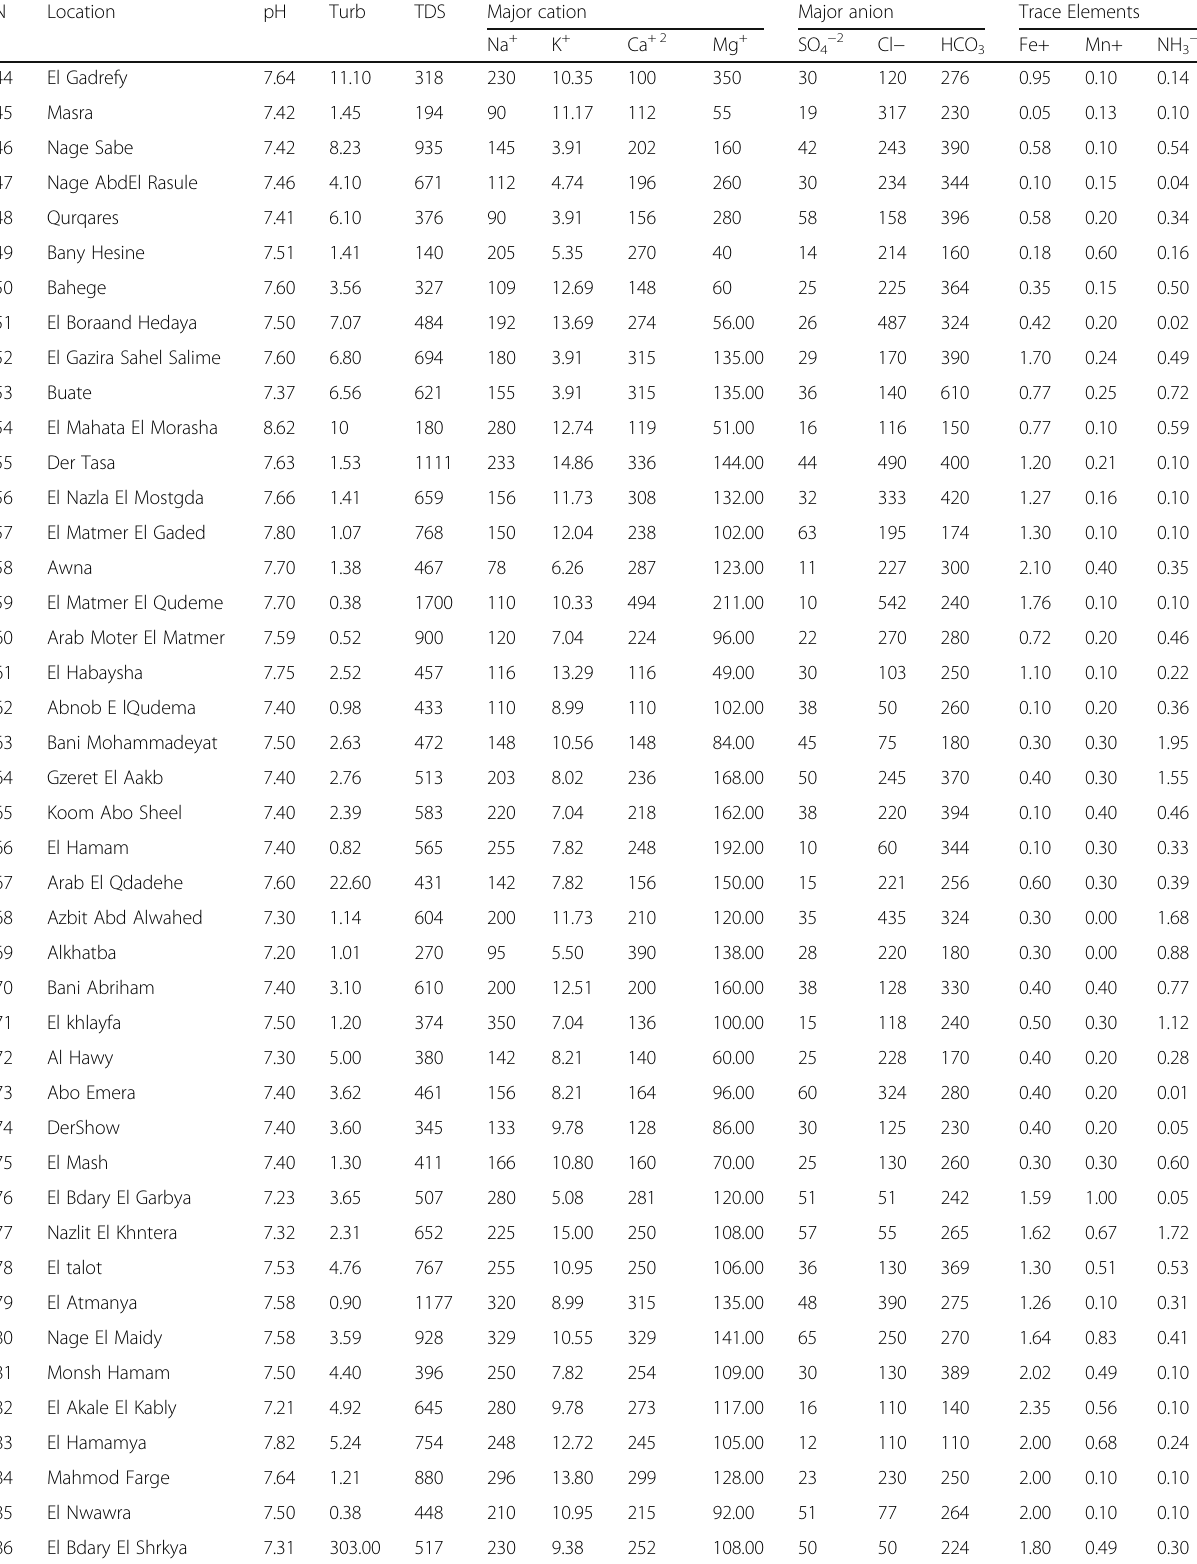
Table 4 Results of chemical analyses of studied groundwater samples in Assuit Governorate